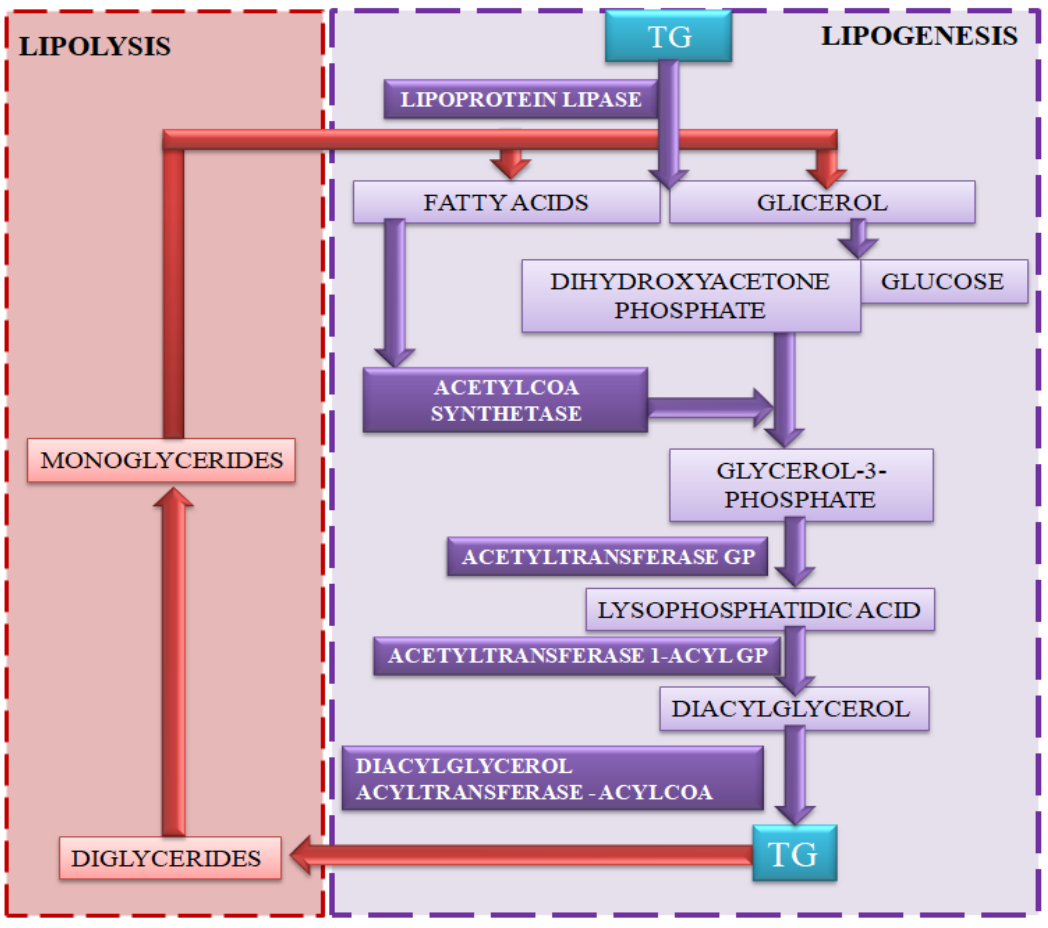
Scheme 3. Metabolism of lipids.